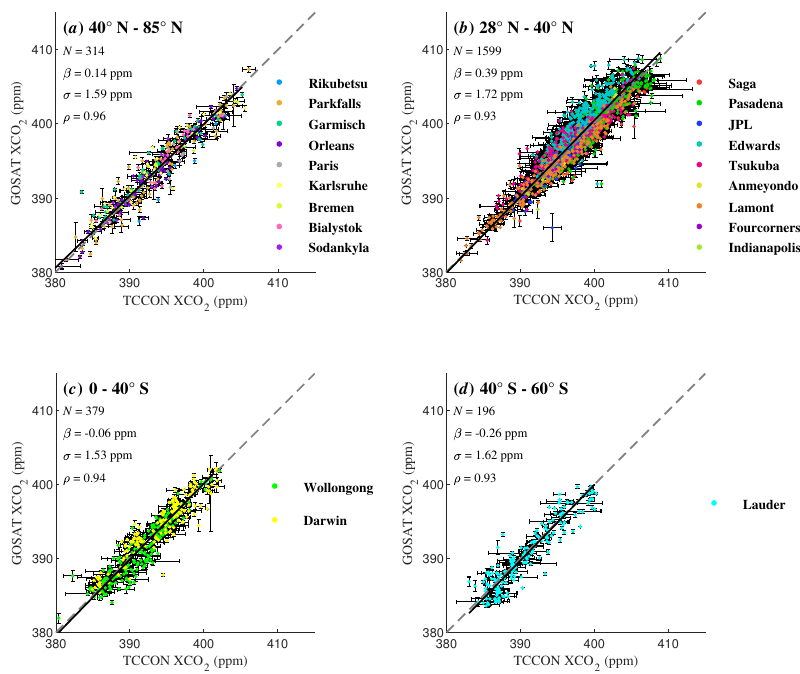
Figure 5. Scatter plots of the collocations of the TCCON and GOSAT XCO 2 in four latitude zones: ( a ) 40 ◦ N–85 ◦ N; ( b ) 28 ◦ N–40 ◦ N; ( c ) 0–40 ◦ S; and ( d ) 40 ◦ S–60 ◦ S. The vertical error bars represent the standard deviations of the GOSAT data, while the horizontal bars represent the standard deviations of the TCCON data. Each TCCON site is represented by a certain color. The latitudes are binned around the TCCON sites.